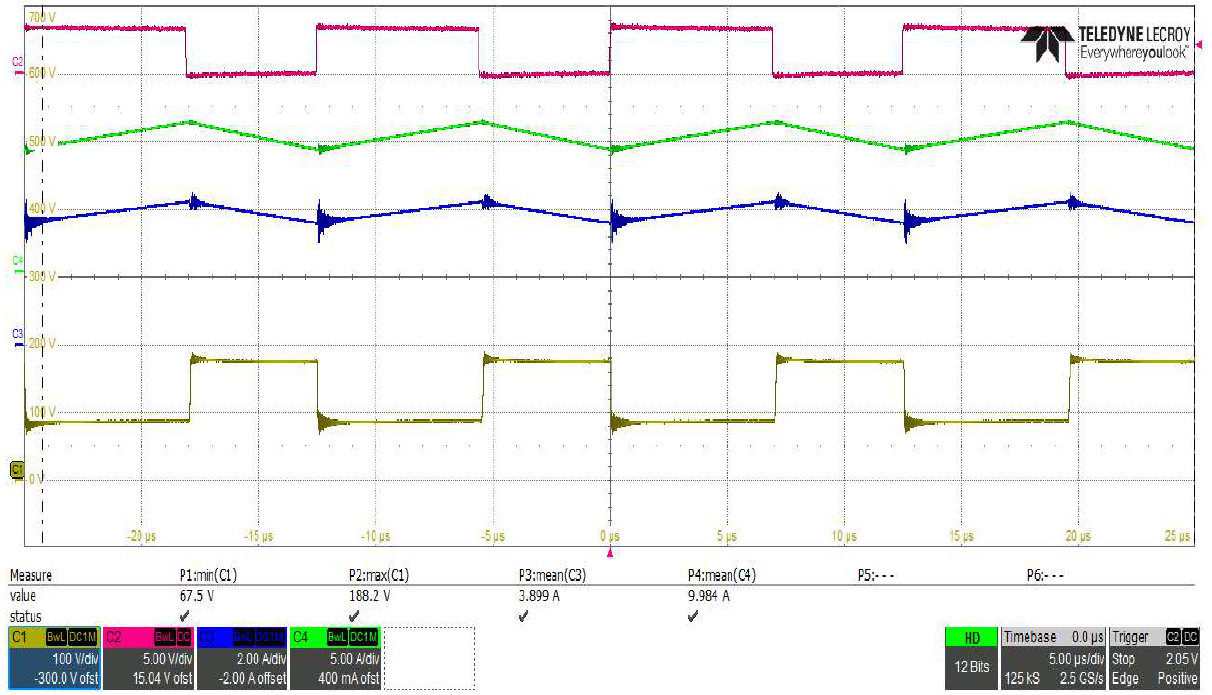
Figure 27. Experimental BHSC waveforms for step-down operation at V H = 125 V, V L = 40 V, and I L = 10 A (controlled). C1: Voltage across the switched-capacitor cell, V Csw ; C2: PWM driving signal; C3: i L2 ; C4: i L1 .